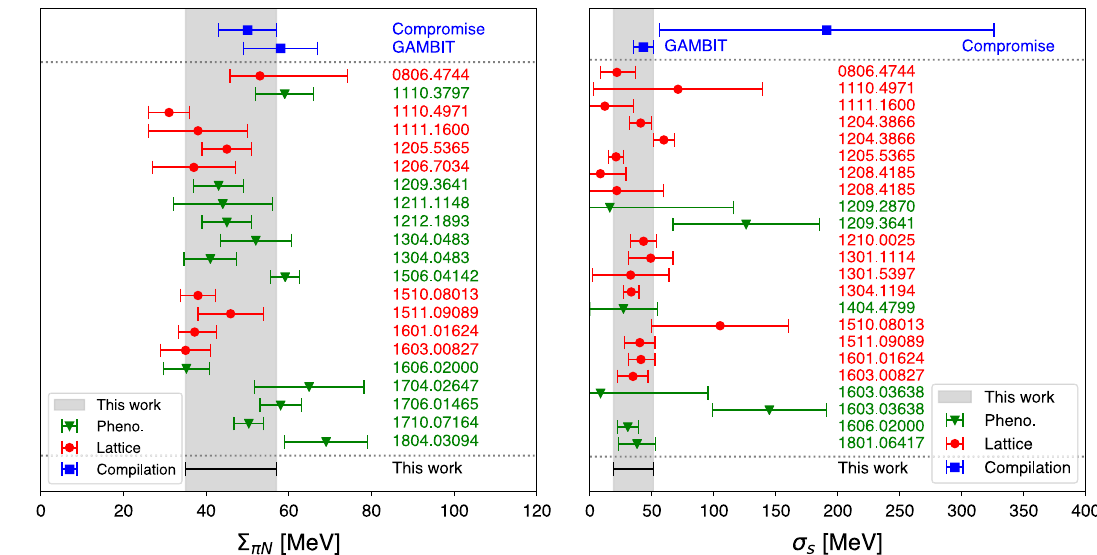
Fig. 2 Left panel: Recent values of (cid:7) π N . Right panel: Recent values of σ s . Calculations based mainly on lattice calculations are indicated in red, and those relying more on phenomenological inputs are indicated